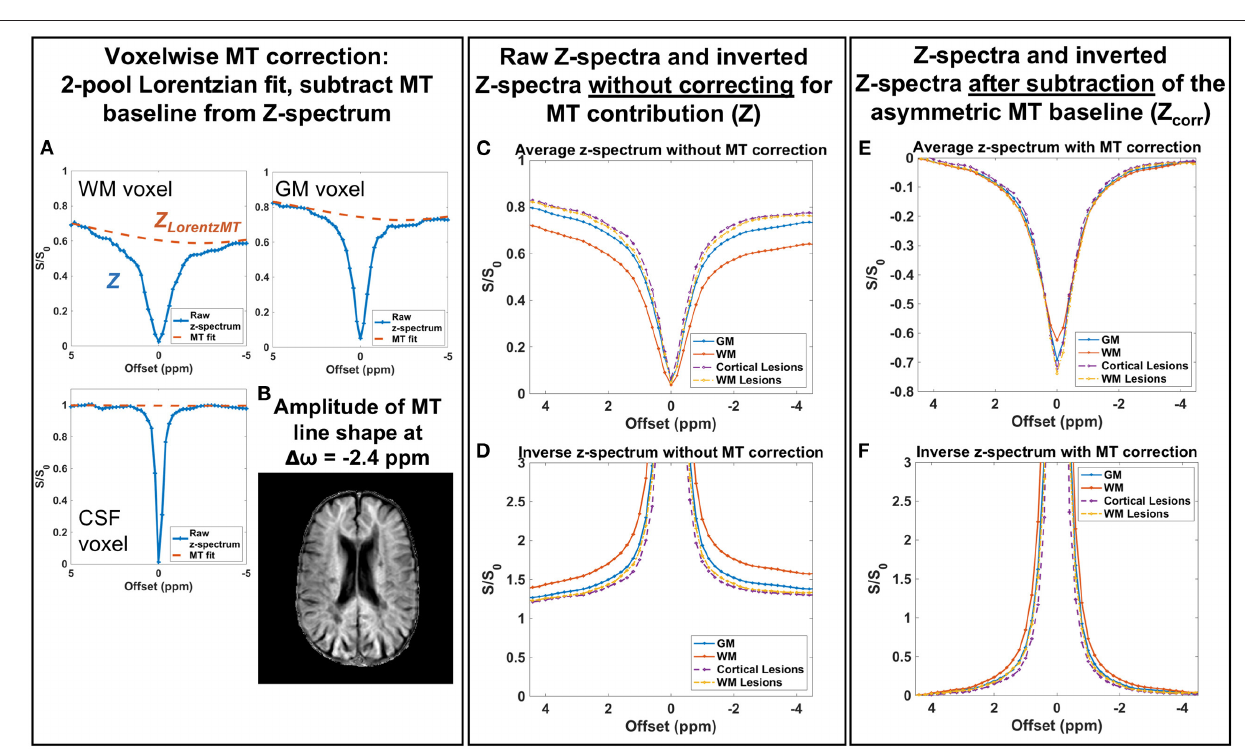
FIGURE 2 | (A) A 2-pool Lorentzian model was fit to the measured z-spectrum (Z) in each voxel and the resulting MT Lorentzian component (Z LorentzMT ) is shown for representative voxels in different tissues. (B) The amplitude of the MT Lorentzian line shape at − 2.4 ppm shows little to no MT contribution in CSF and the largest MT contribution in white matter. (C,D) Raw z-spectra and inverted z-spectra without the MT correction show differences due to broad MT saturation effects. (E,F) After subtracting the MT baseline, differences between gray and white matter z-spectra and inverted spectra due to MT effects are minimized. Example spectra shown are from a patient with MS (46-year-old male, EDSS = 4, duration = 16